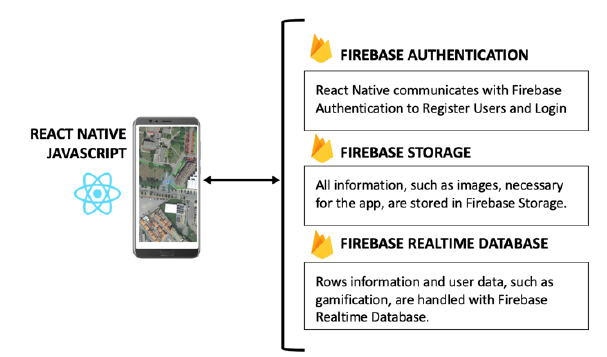
Figure 2. Technological Architecture